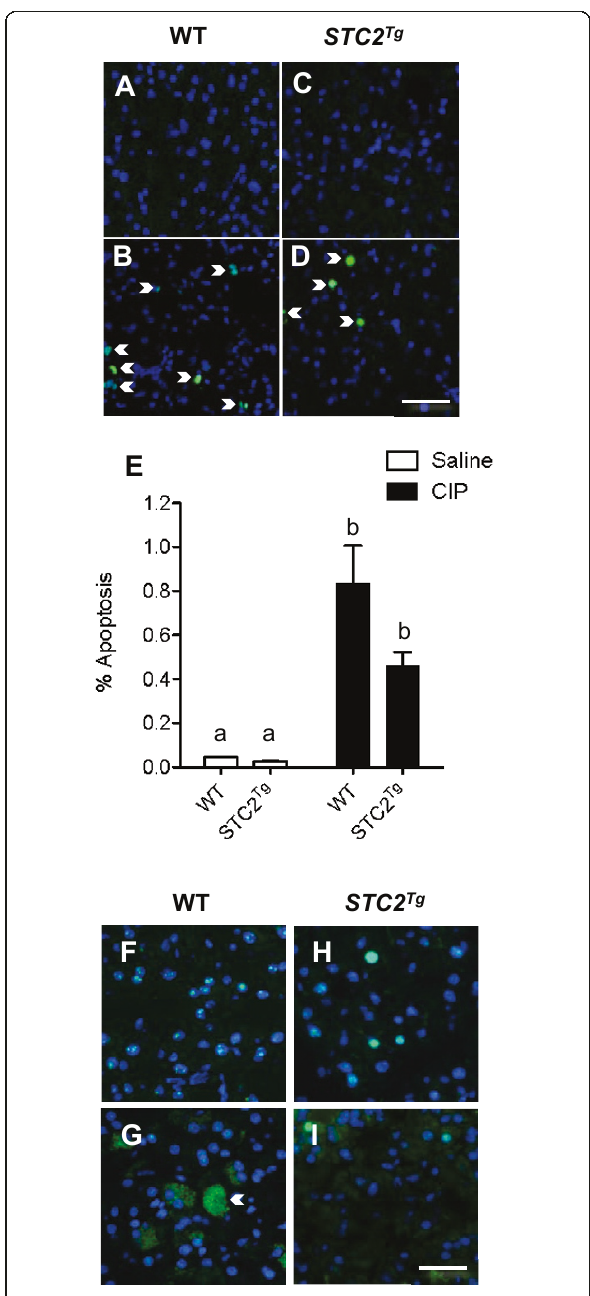
Figure 6 Cell death is decreased during CIP in STC2 Tg tissue . TUNEL analysis revealed apoptosis (arrowheads) during CIP ( B, D ) but not saline injections ( A, C ) in WT ( A , B ) and STC2 Tg ( C , D ) pancreata. Magnification bar = 45 μ M. (E) Quantification of TUNEL positive cells in WT and STC2 Tg tissue (n = 4 animals; letters indicate significant differences). (F-I) HMGB1 IF to identify necrosis revealed nuclear localization in saline conditions for WT ( F ; n = 3 animals) and STC2 Tg ( H ; n = 3 animals) tissue. After induction of pancreatitis, patches of cells with cytoplasmic, punctate HMGB1staining, indicative of necrosis, were observed in WT tissue ( G ; n = 4 animals) but not in STC2 Tg tissue ( I ; n = 4 animals). Magnification bar = 34 μ